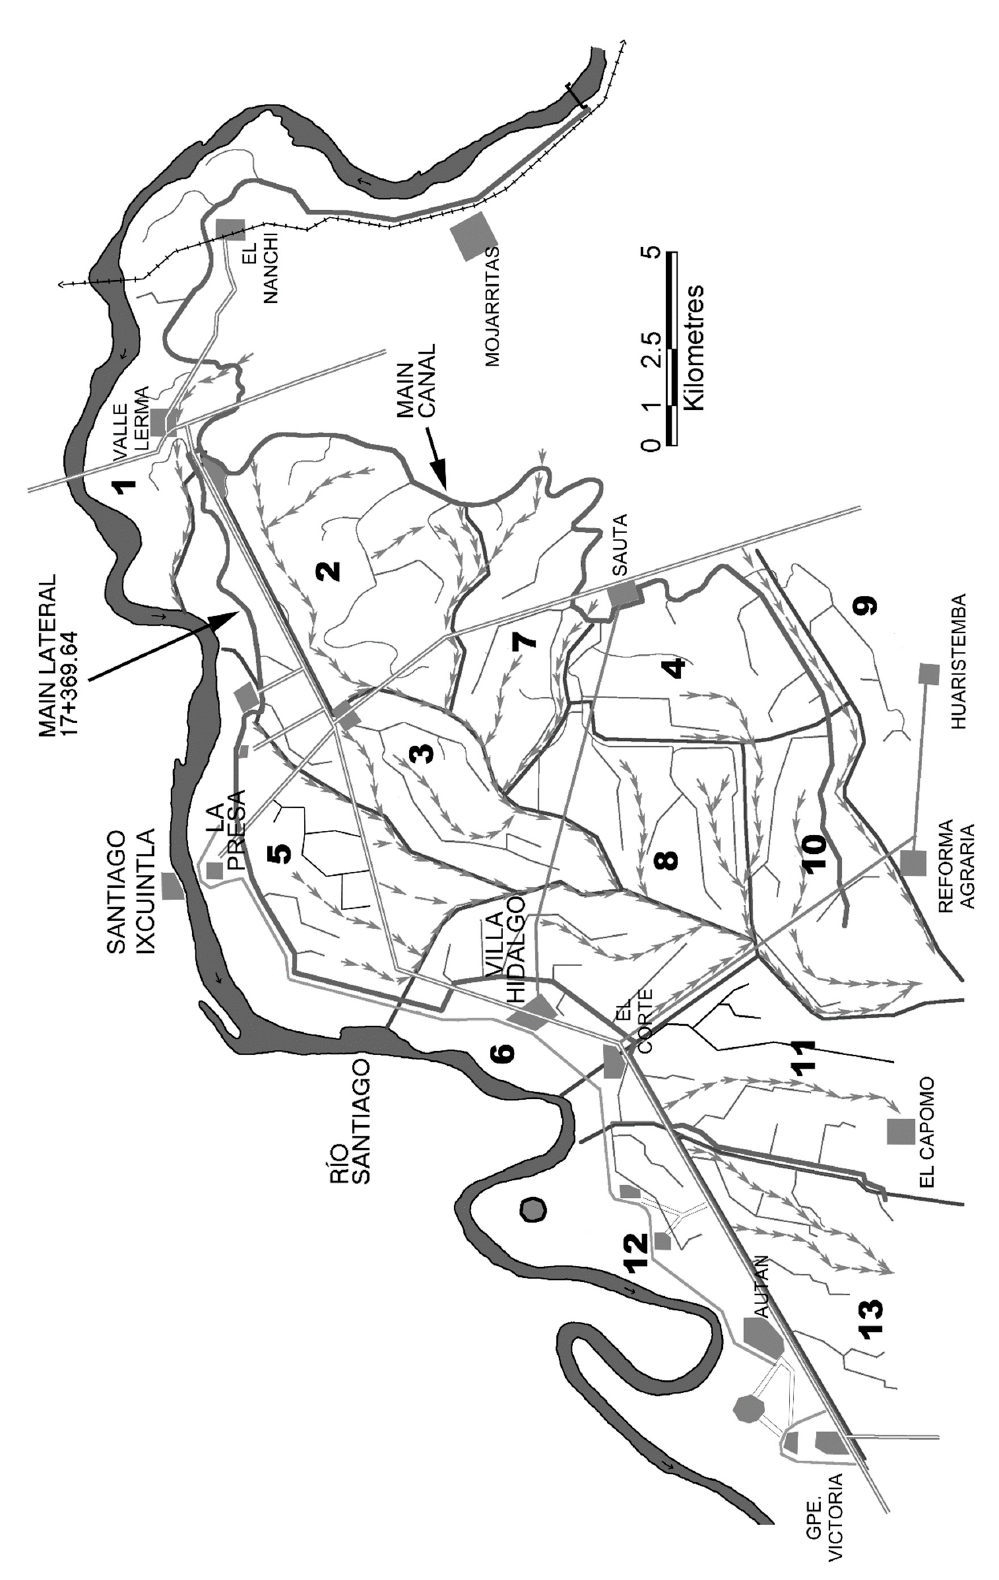
Figure 5. Operational sections of The Left Bank.